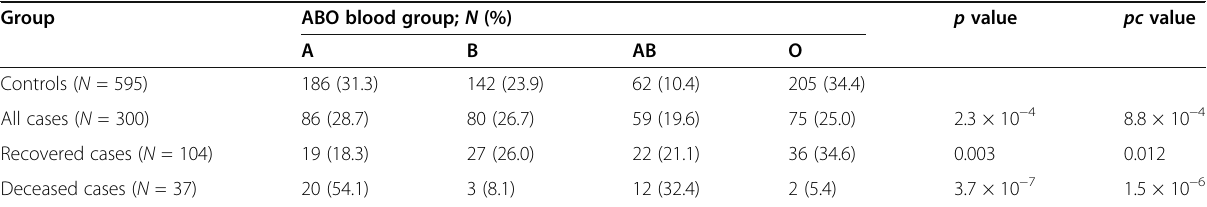
Table 2 Phenotype frequencies of ABO blood groups among coronavirus disease 2019 cases and controls Group ABO blood group; N